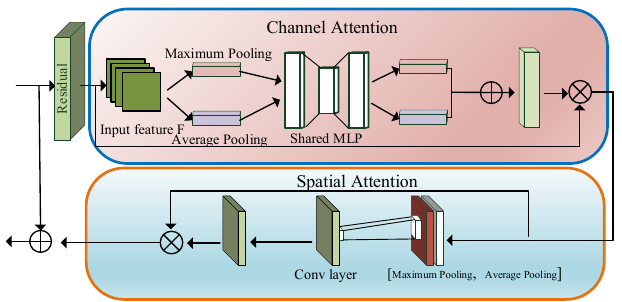
Figure 3. The structure of the attention module (RM).